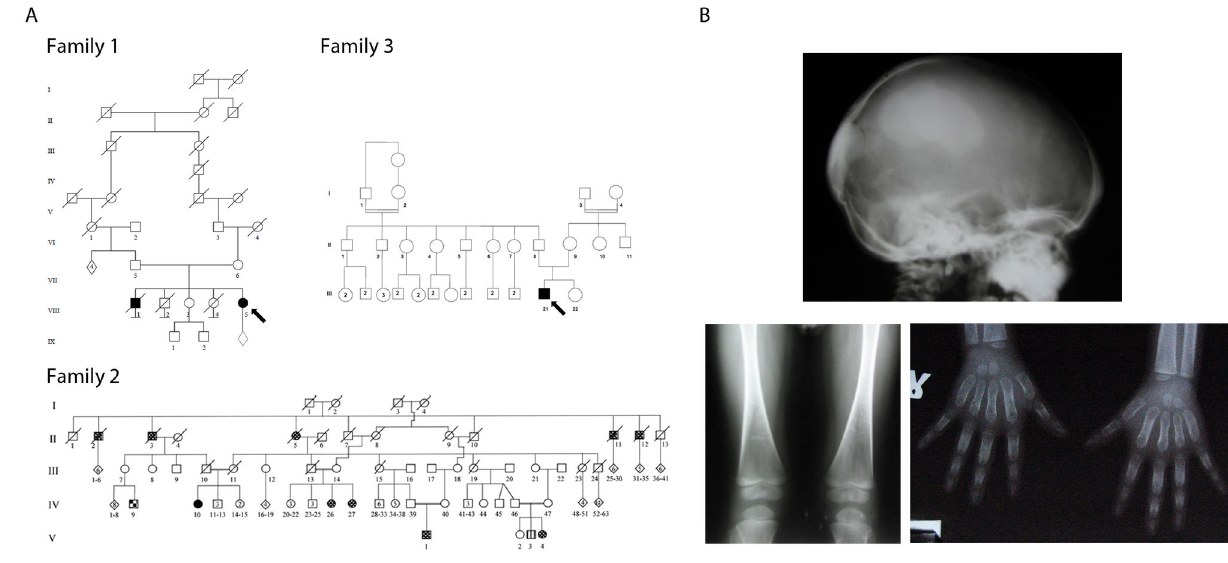
Figure 1. Pedigree information and case description. (A) Pedigrees of Families 1, 2 and 3 with mutation in the novel CMD gene GJA1 . Proband DNA from Family 1 was used for exome sequencing (Arrow). (B) Radiographic images of proband for Family 3 show hyperostosis of cranial base and facial bones, femoral flaring and undertrabeculation of metaphyses with dense diaphyseal bone consistent with findings in Family 2. Diffuse widening of the proximal and medial phalanges are consistent with findings in CMD patients from Family 2